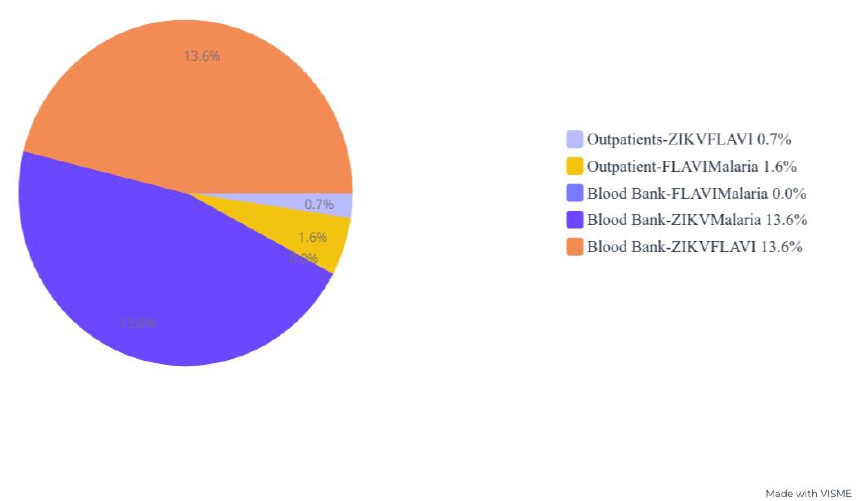
Figure 2. Blood product antibody seropositivity.